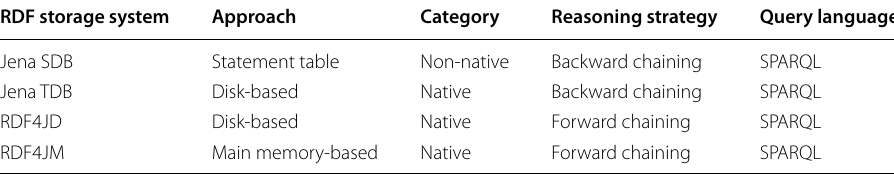
Table 2 Characteristics of proposed RDF storage systems